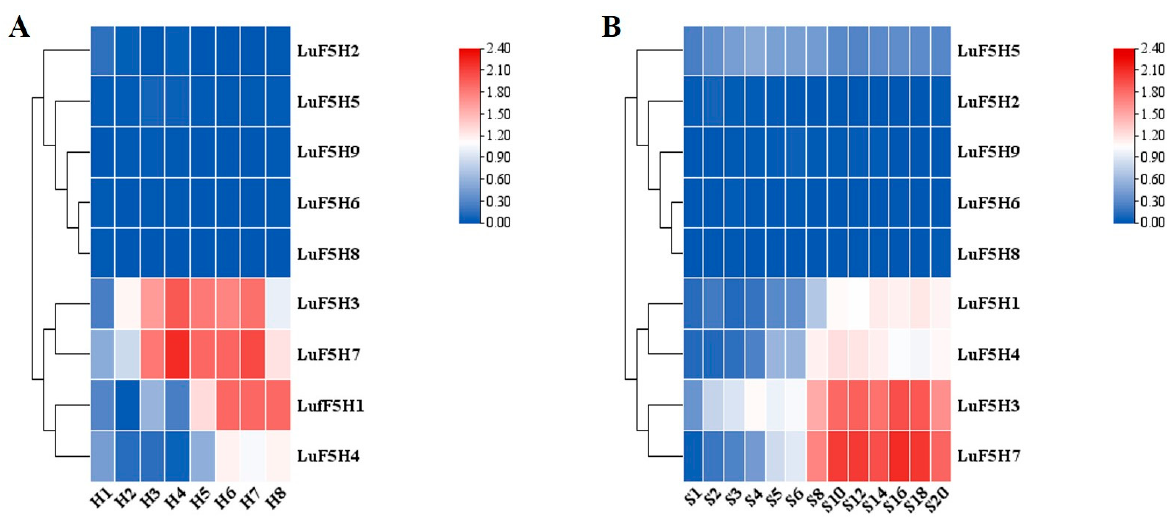
Figure 5. Expression patterns of LuF5H genes in flax. ( A ) Different developmental stages: H1 seedling stage, H2 fir-like stage, H3 early fast-growing stage, H4 fast-growing stage, H5 bud stage, H6 flowering stage, H7 green stage, and H8 maturity stage. ( B ) Different parts: flax stems of fast-growing stage were divided into 20 equal parts that were named S1–S20. S1 is closest to the shoot apex, and S20 is closest to the root. Red represents a high expression level, and blue represents a low expression level.